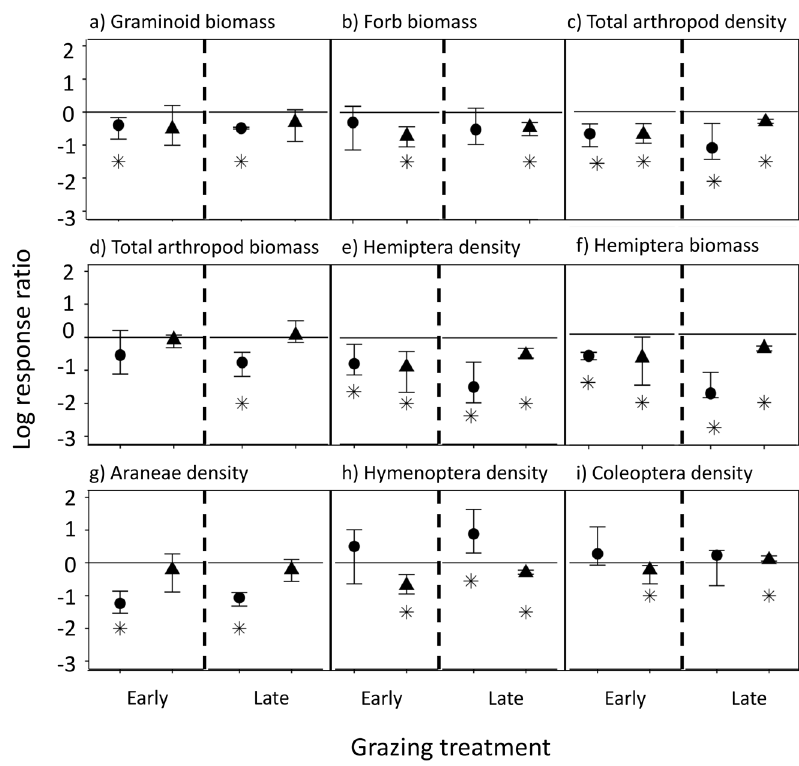
Figure 4. Effect sizes (log response ratio) for end-of-season plant and arthropod variables in wet meadow and upland grasslands. Wet meadows are represented with a circle and uplands with a triangle. The log response ratio compares grazing treatments to control and asterisks (*) denote significant effect sizes at a =0.05. Error bars are bias-corrected 95% confidence intervals. Due to similar results for density and biomass for Araneae, Hymenoptera, and Coleoptera, we only report effect sizes for arthropod density. Diptera and Orthoptera density and biomass in grazed treatments were not significantly different from controls.